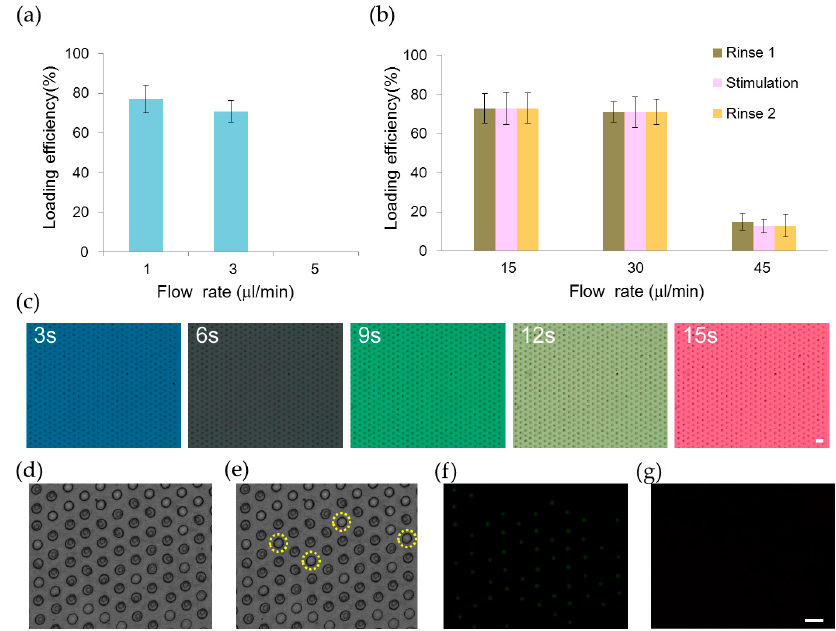
Figure 2. Loading and perfusion of human L cell line NCI-H716 cells in the microfluidic chip. ( a ) Loading efficiency of NCI-H716 cells into microwells at different flow rates controlled by using a syringe pump; ( b ) Relationship between the loading efficiency and the flow rate of the perfusion solution. Three solutions (rinse 1, stimulation, rinse 2) were introduced into the device sequentially. The flow rate of 15, 30, and 45 μ L/min was generated by applying compressed air of pressure 5, 10, and 15 psi to the inlet, respectively; ( c ) Five different dye solutions are introduced sequentially into the microfluidic chip by applying a pressure of 10 psi to the inlet. Micrographs are taken at every 3 s. A sequence of micrographs showing ( d ) NCI-H716 cells that are loaded into microwells; ( e ) Four cells that are dislodged after rinsing with a buffer solution; ( f ) Live and ( g ) dead cell staining of NCI-H716 cells after one day of incubation. Live cells appear green while dead cells appear red under the fluorescence microscope. Scale bar = 50 μ m.